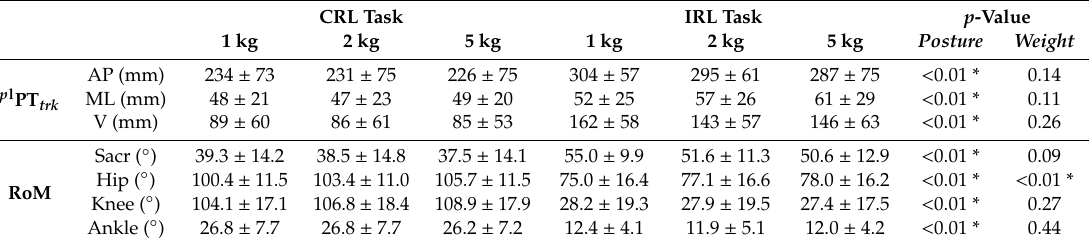
Table 2. Mean, standard deviation, and p- values of the main e ff ects Posture and Weight of a 2 × 3 two-way repeated measures ANOVA for the three components of the p l PT trk vector (the displacement in the 3D space between the pelvis and trunk body segments); the range of motion of the lumbosacral joint and the right lower limb joints estimated through the biomechanical model (BM) in the correct releasing loads (CRL) and incorrect releasing loads (IRL) tasks.* marks significant di ff